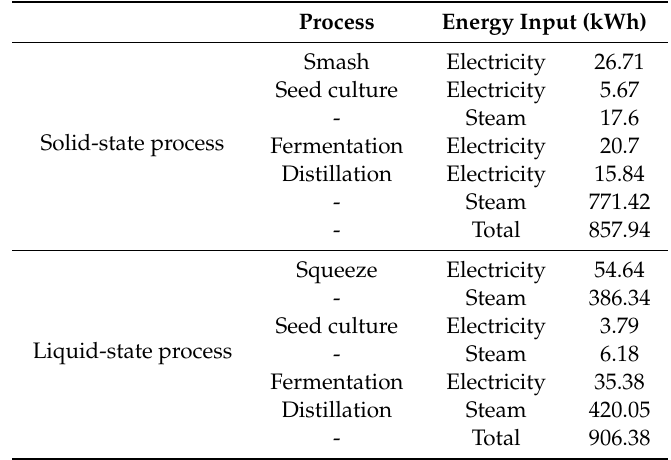
Table 5. Energy input sheet of solid and liquid process based on 1 ton 26.3 wt% crude ethanol.